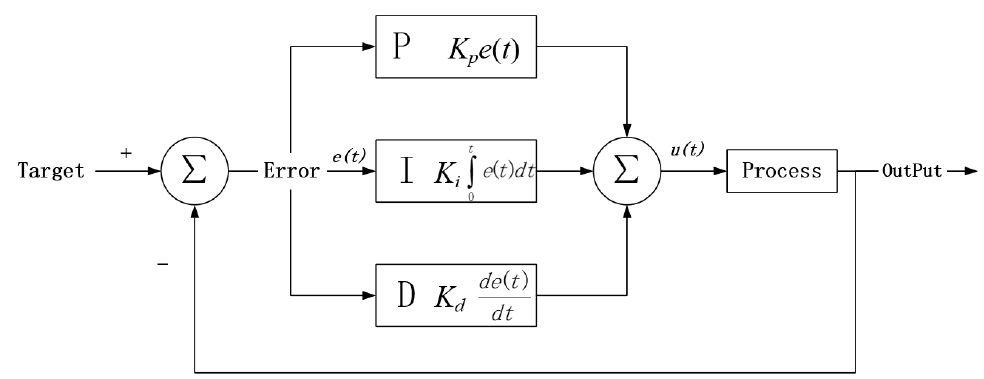
Figure 2. Structure of PID system.